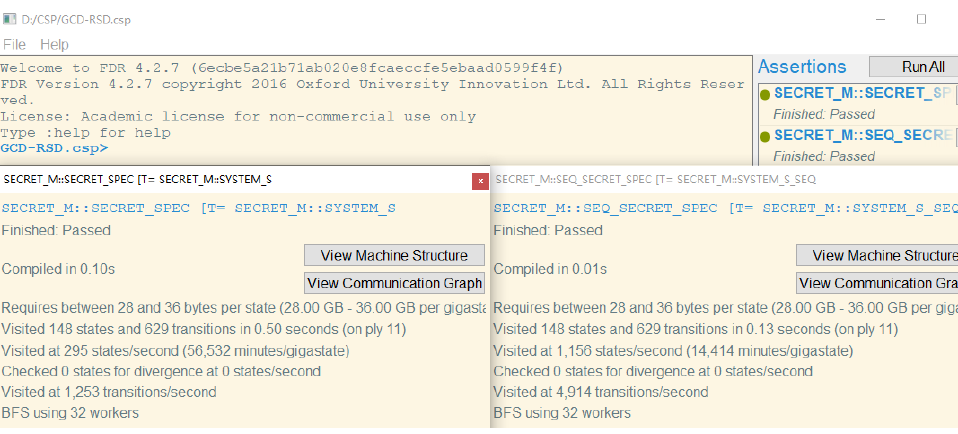
Figure 4. The formal verification results of GCD-RSD using